Question: Summarize what this figure shows in one sentence.
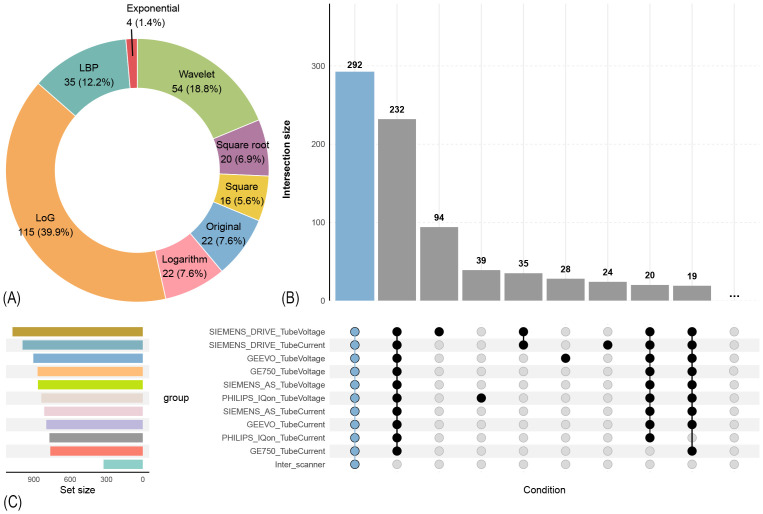
Answer: Distribution of stable radiomic features. (A) Donut chart. The chart illustrates the compositional distribution of the 292 stable features across different transformation categories, with embedded values indicating the number of features (and corresponding percentages) in each category. (B) Venn diagram. Each bar in the diagram denotes the number of radiomic features that were stable in the group corresponding to the highlighted section at the bottom, but unstable in the other groups. (C) Bar chart. This chart quantifies the total count of stable radiomic features in each test group. GE750, Discovery CT750 HD (GE); GEEVO, Revolution EVO (GE); PHILIPS_IQon, IQon Spectral CT (Philips); SIEMENS_AS, SOMATOM Definition AS+ (Siemens); SIEMENS_Drive, SOMATOM Drive (Siemens); LoG, Laplacian of Gaussian; LBP, local binary pattern.